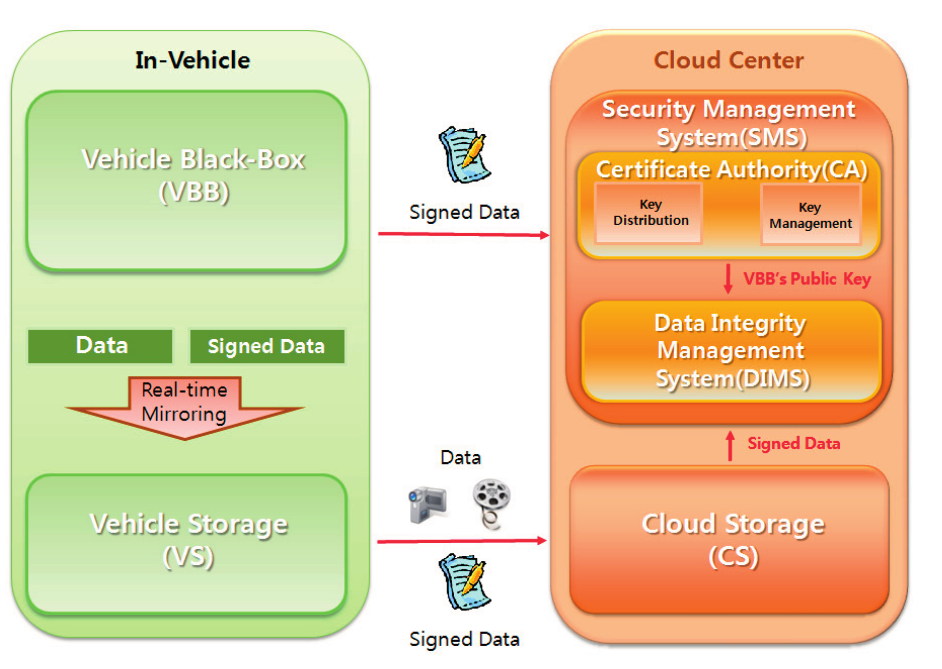
Figure 1. Architecture of the vehicle black box service model